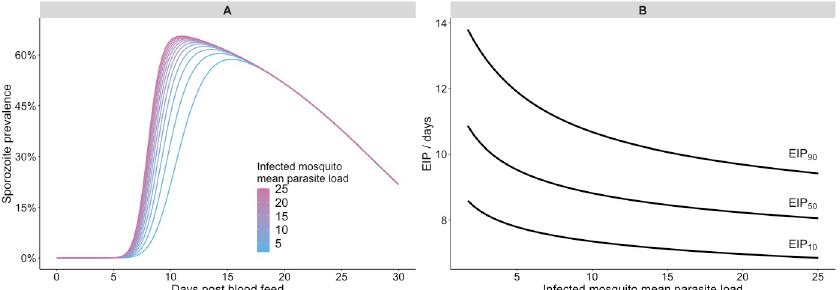
Fig 5. Modelled impact of parasite load on the extrinsic incubation period. Panel A shows the impact of varying the mean parasite load of infected mosquitoes on the temporal dynamics of sporozoite prevalence in a sensitivity analysis; panel B summarises how the EIP is affected by the same parameter in the sensitivity analysis. All other parameters were held constant at their mean posterior values.